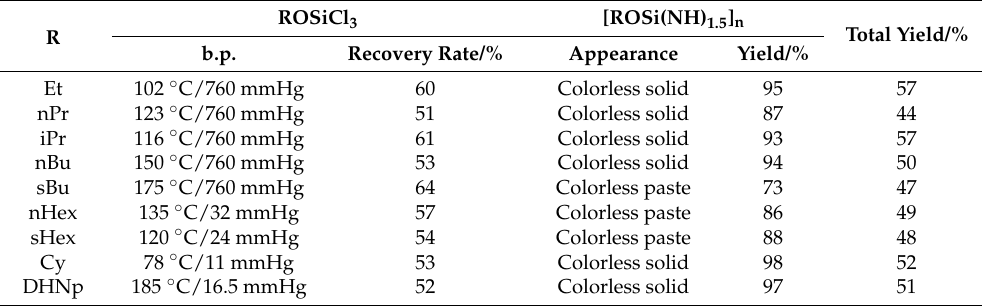
Table 1. ROSZs synthesized in this study. DHNp: